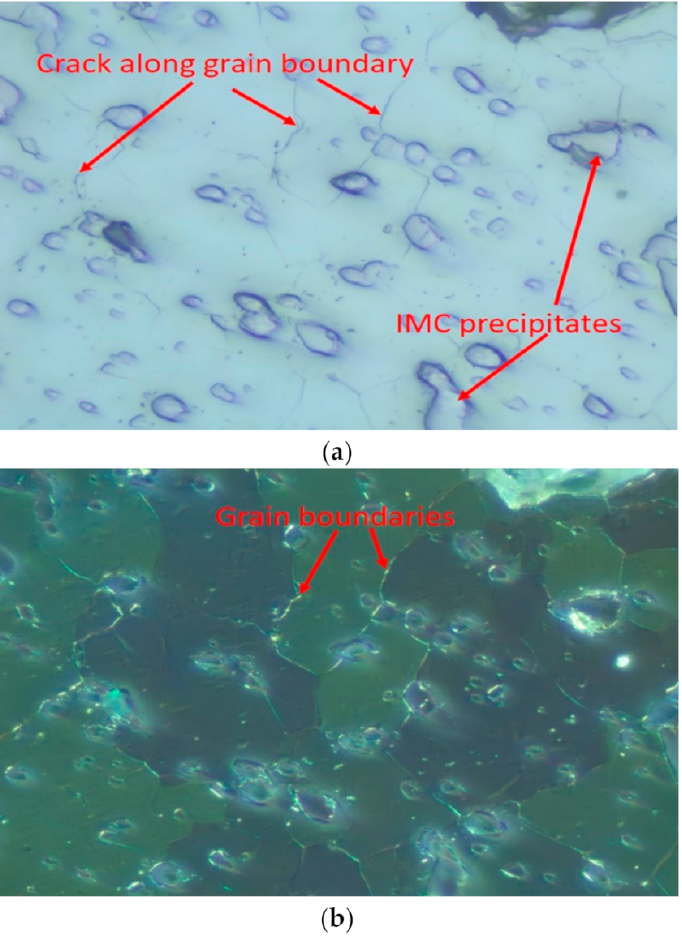
Figure 12. Schematic image of recrystallization after thermal cycling; ( a ) dark field image; and ( b ) polarized